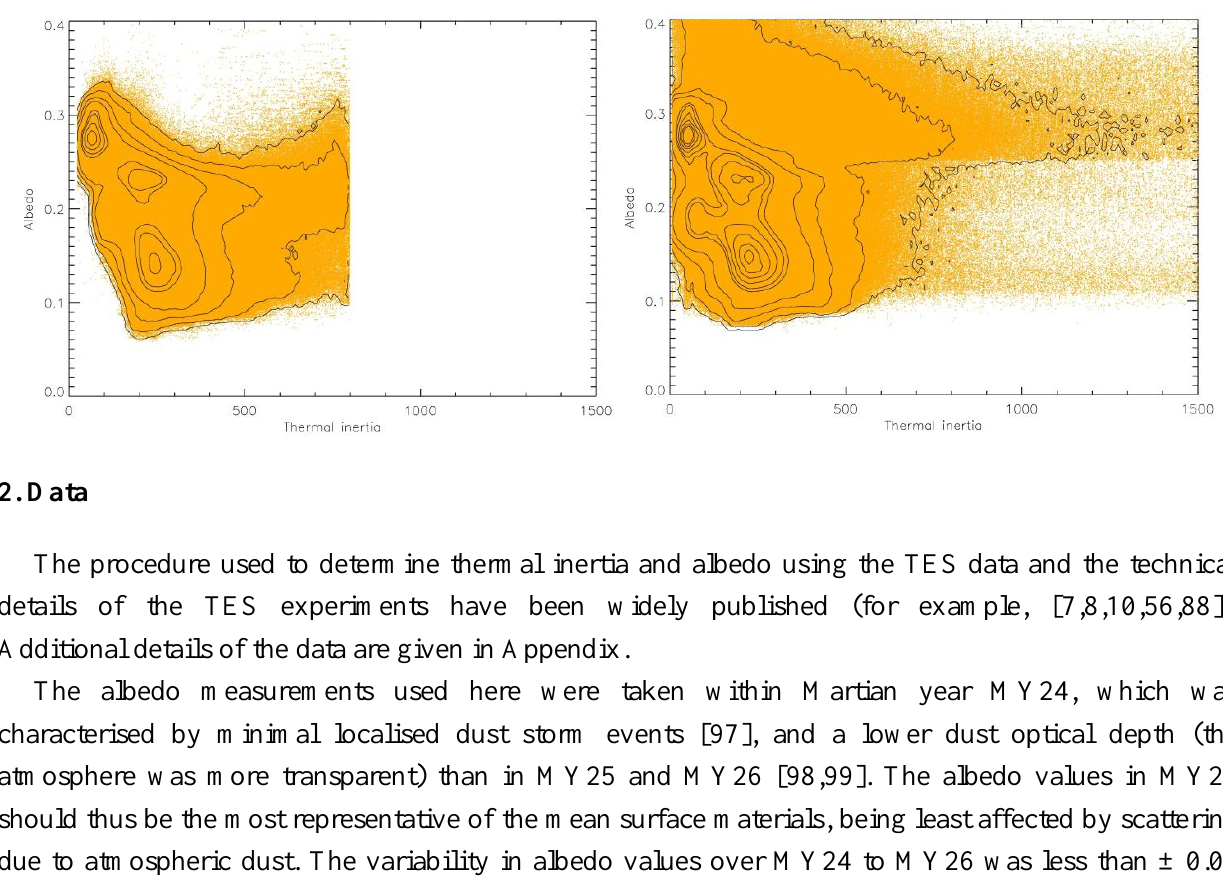
Figure 2. Scatterplot with contours in thermal inertia and albedo values. ( Left ) is the older datasets used by [8]; ( Right ) is the albedo and updated thermal inertia used in this work. Binsize for contours is 10.0 in thermal inertia and 0.005 in albedo. Contours are placed at counts: 40, 2 × 10 2 , 1 × 10 3 , 3 × 10 3 , 1.5 × 10 4 , 2 × 10 4 , 3 × 10 4 , 4.2 × 10 4 , 5.5 × 10 4 , 6.5 × 10 4